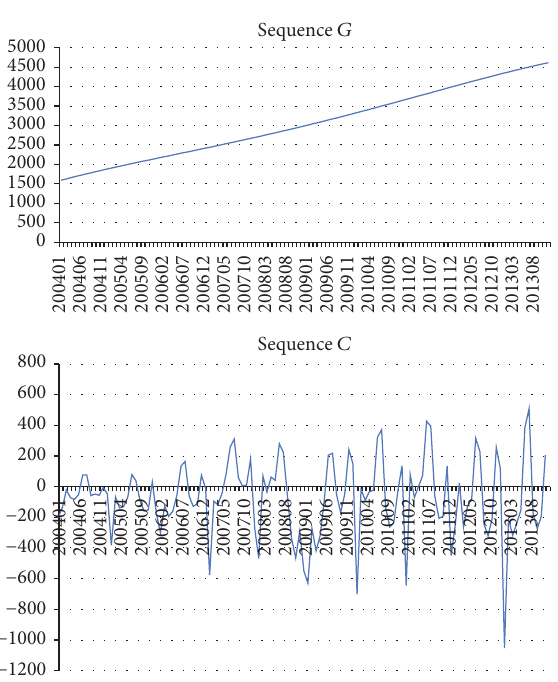
Figure 5: Data separation based on HP